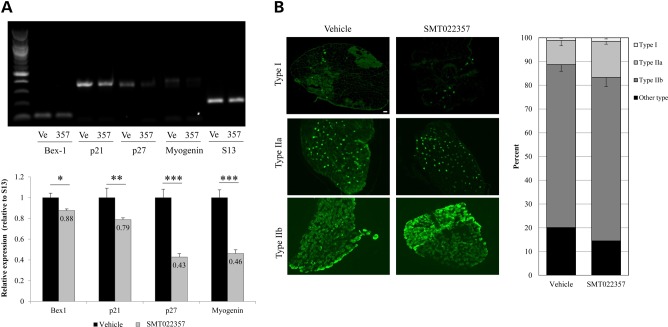
SMT022357 treatment results in a decrease in regeneration with no change in fibre type composition in the skeletal muscle. (A) Semi-quantitative RT-PCR demonstrates a decrease of skeletal muscle regeneration/myogenic differentiation markers Bex1, myogenin and cell cycle dependent-kinase inhibitors (CDKI) p21 and p27 from EDL of mdx mice dosed with SMT022357 (357, n = 8) compared to vehicle (Ve, n = 8). S13 ribosomal protein was used as an internal control for the RT-PCR. A 12% decrease in Bex1 (P = 0.034), 21% decrease in p21 (P = 0.002), 67% decrease in p27 (P < 0.001) and 64% decrease in Myogenin (P < 0.001) transcript levels were quantified by ImageJ software in SMT022357 group compared to vehicle. (B) Immunofluoresence staining for type 1a, 2a and 2b fibre types in the EDL of 7 weeks old mdx mice treated for 5 weeks with 30 mg/kg/day SMT022357 or vehicle (n = 6 per group). Sections were stained with anti-MYHC1, anti-MYHC2A anti-MYHC2B and anti-mouse secondary antibody. Percentage of type 1a, 2a and 2b fibre types was quantified by ImageJ software in the whole EDL muscle (n = 6 per group). No change was observed in fibre type composition of whole EDL muscle treated with SMT022357 compared to treatment with vehicle only. Scale bar: 100 µm.